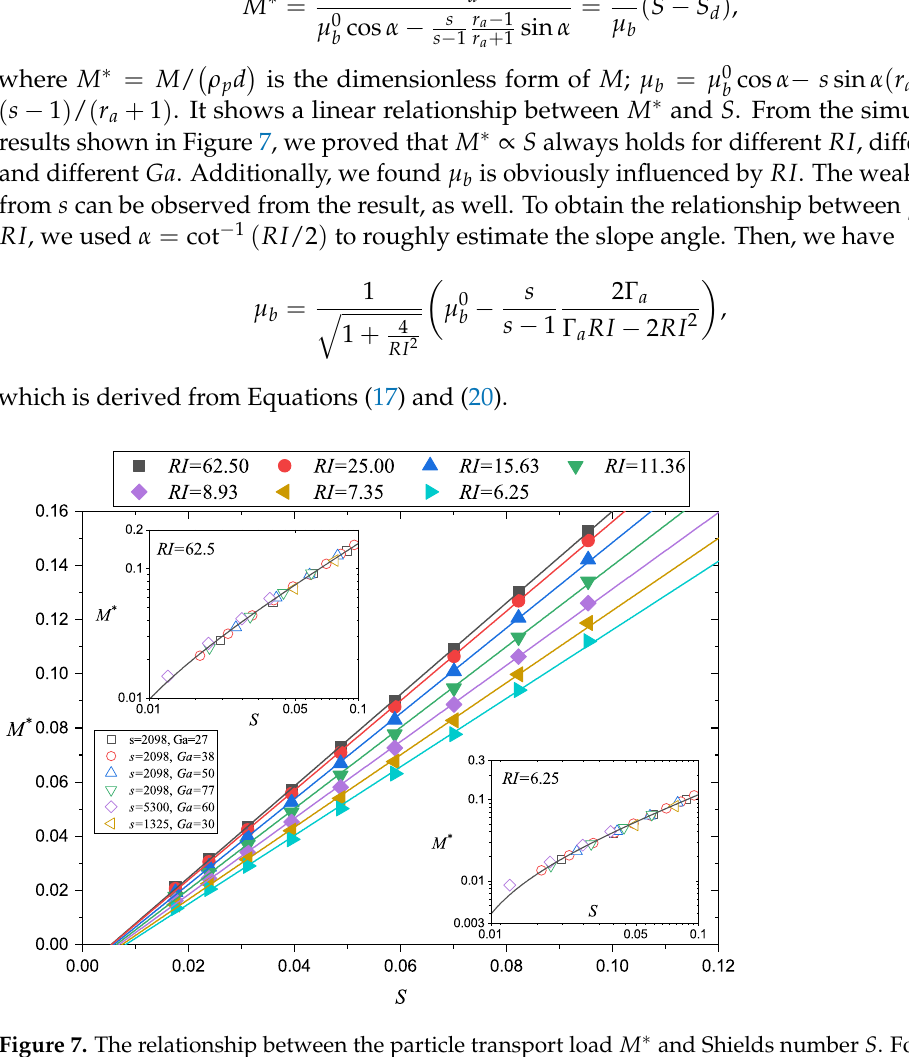
Figure 7. The relationship between the particle transport load M ∗ and Shields number S . For filled symbols, different colors correspond to different RI . For hollowed symbols in the insets, different colors correspond to different particle/fluid properties. Two insets show the results of two specific RI . All the solid lines represent linear